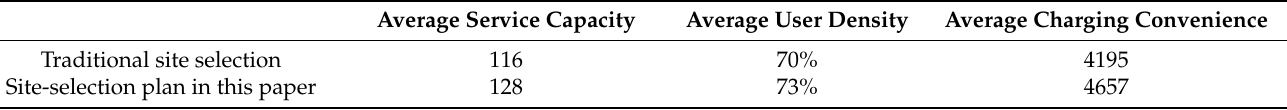
Table 3. Comparison of two site-selection schemes.